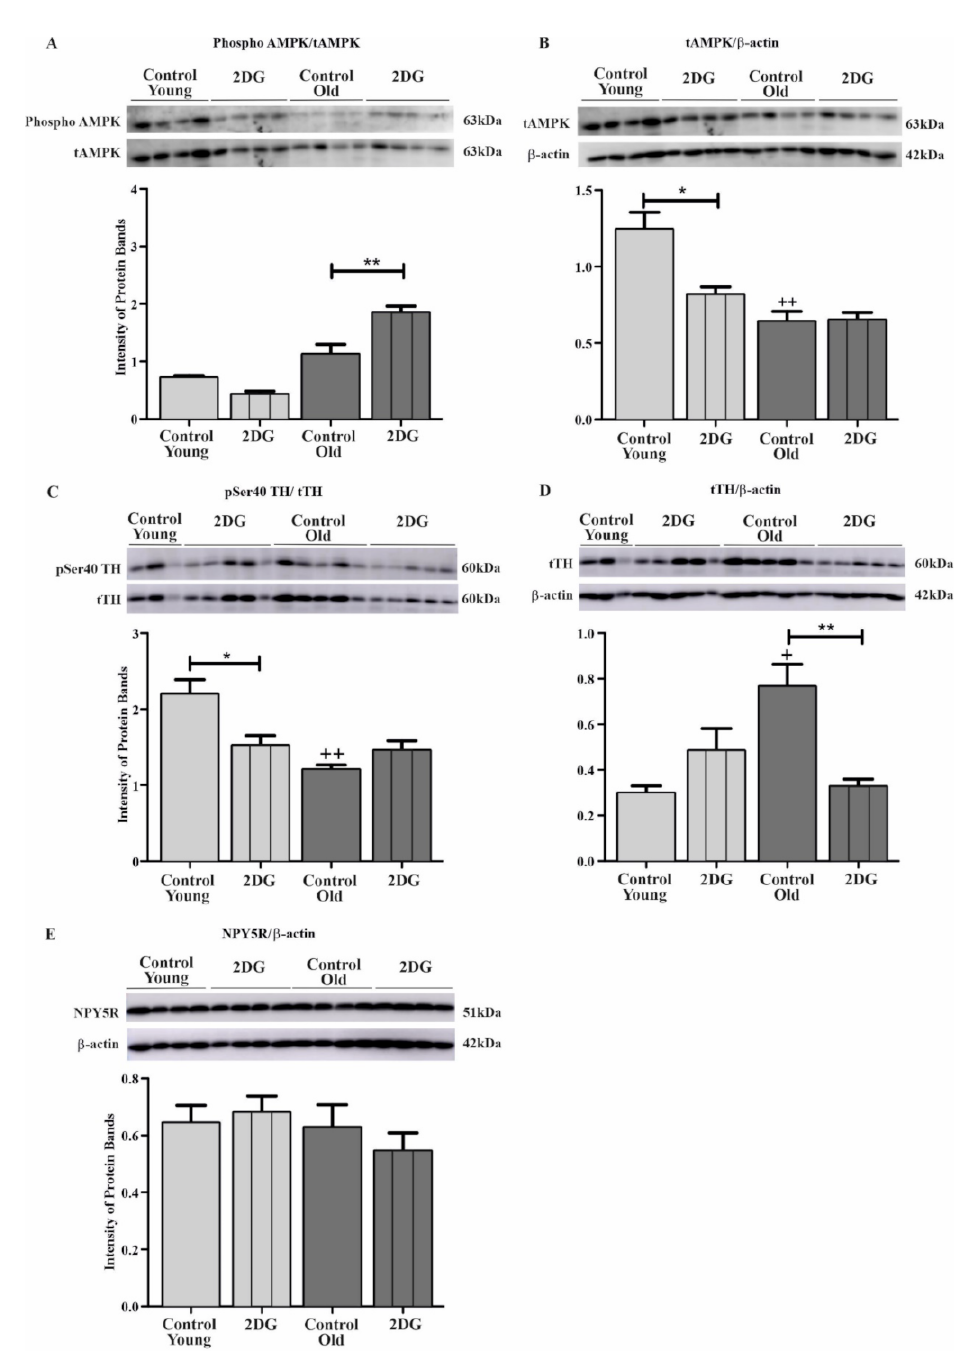
Figure 3. Effects of age and glucoprivation condition on the level of phosphorylated AMPK ( A ), total AMPK (tAMPK) ( B ), pSer40 TH ( C ), TH ( D ), and NPY5R ( E ). Each bar and associated error bar represents mean value of the intensity band ± SEM from one experiment ( n = 6 per group). Representative Western blots ( A – D ) depicting effects of age and 2DG or saline; each lane represents a single animal. ++ ( p < 0.01) and + ( p < 0.05) represent significant differences between control groups of young and old rats, respectively, and ** ( p < 0.01) and * ( p < 0.05) represent significant differences between 2DG and control groups of the same-aged